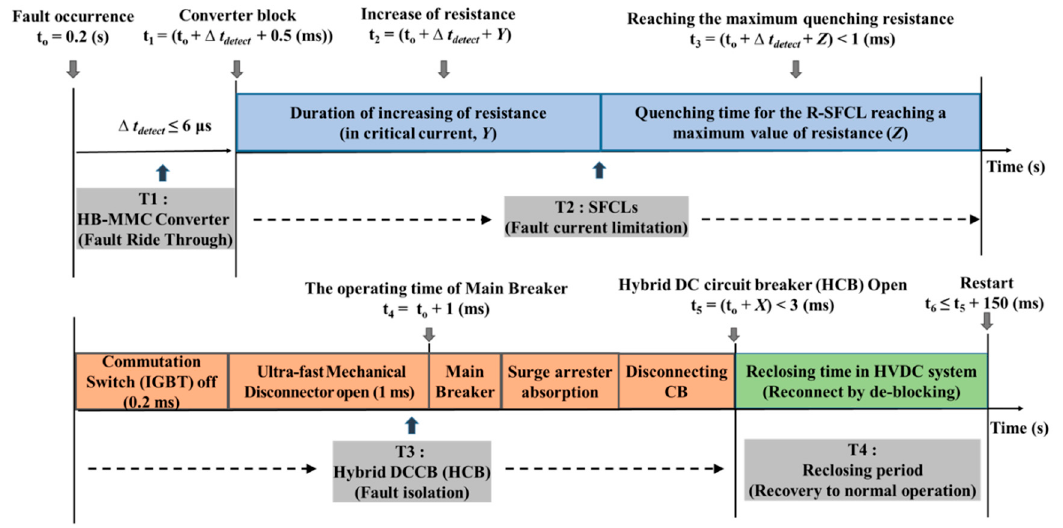
Figure 7. Protection coordination with SFCLs, HCB and HB-MMC.